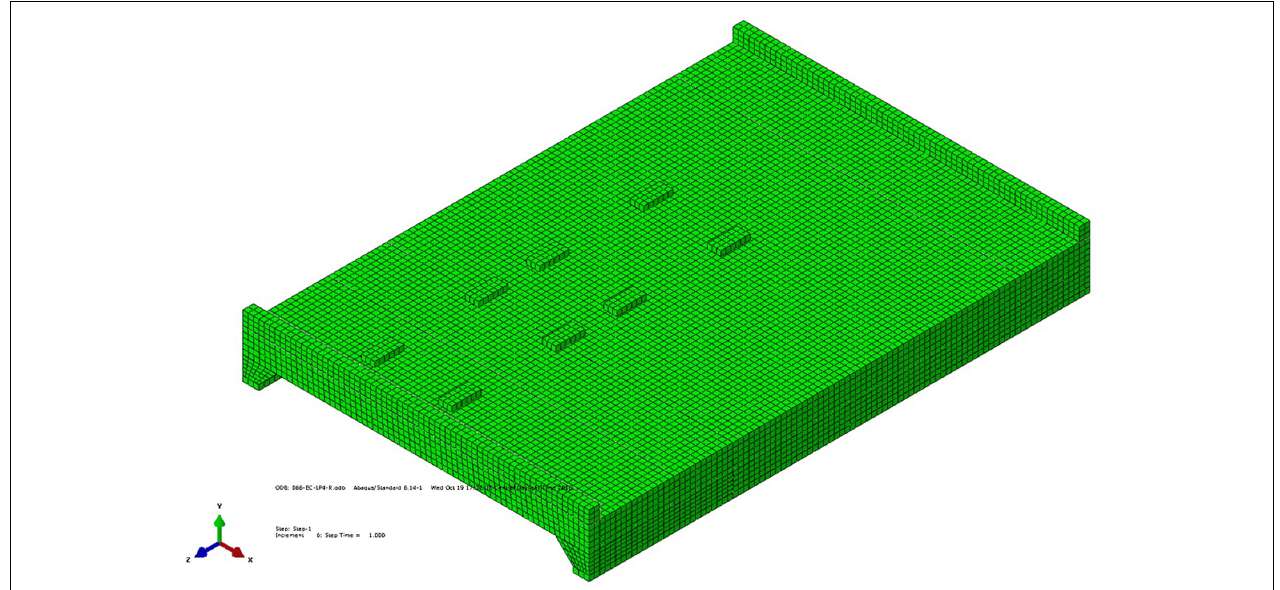
FIGURE 7 | Isometric view of the FE Model of the Bridge. ALDOT Test Trucks footprint pattern